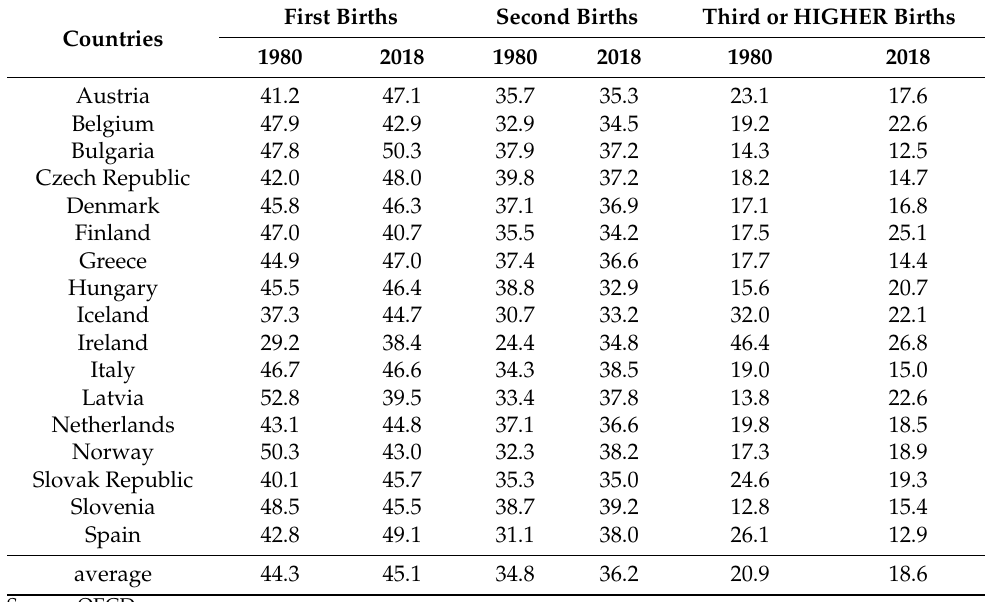
Table 1. Distribution of births by birth order.